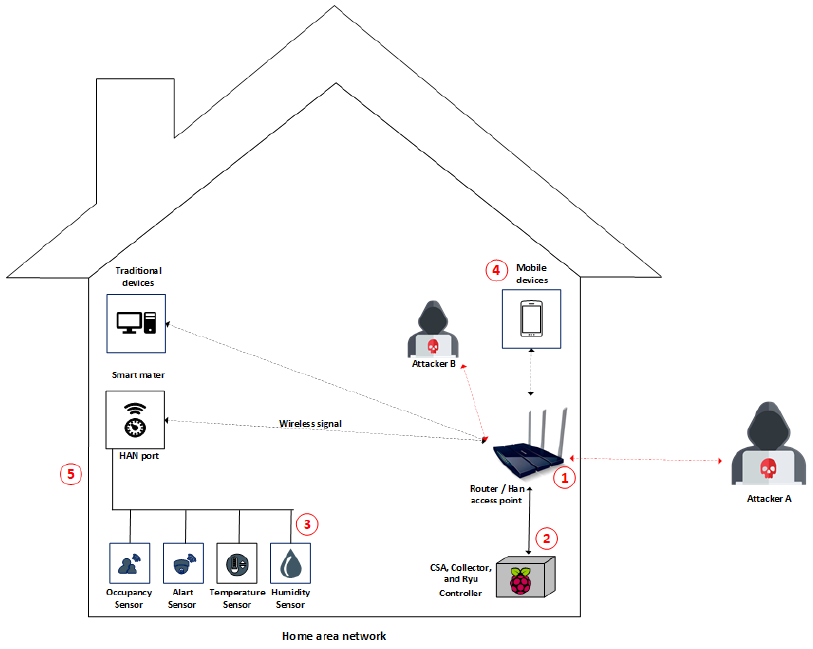
Figure 11. Threat points that can compromise the security of home area